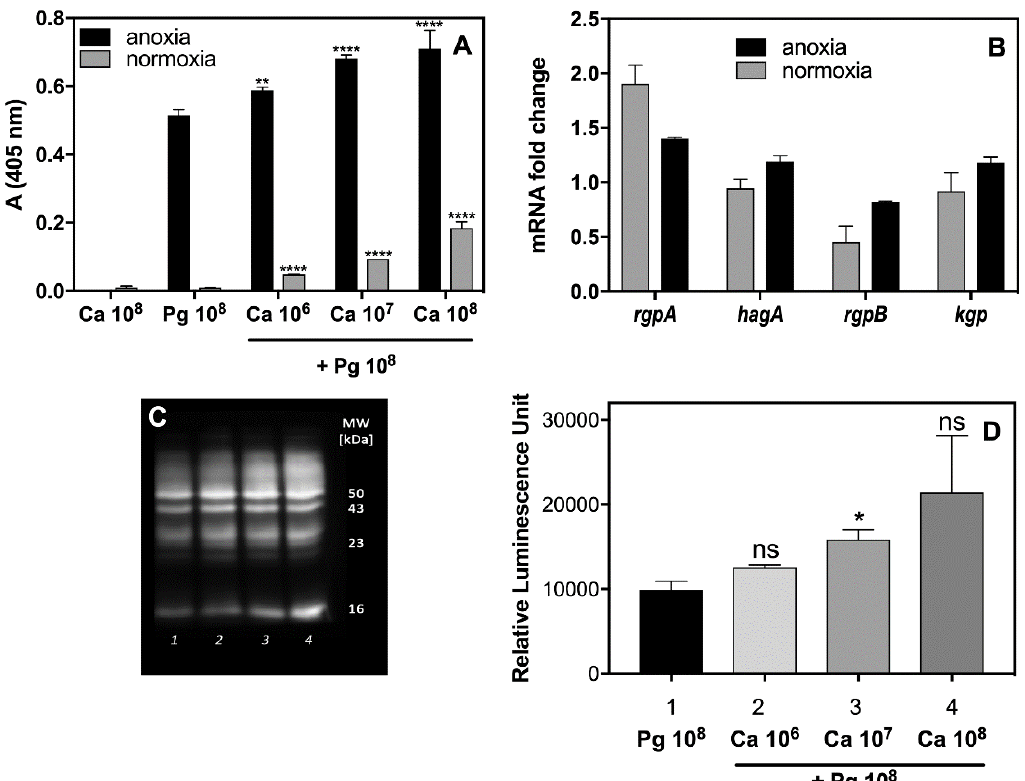
Figure 2. Changes in the gingipain activity and protease production by P. gingivalis growing within a C. albicans biofilm. ( A ) In assays for Rgp activity and ( C , D ) protein expression, the P. gingivalis cells grew (1) alone or in the presence of fungal cells at an MOI of (2) 100:1, (3) 10:1, (4) 1:1 for 24 h. The activity of Rgp was determined using BAPNA as the substrate followed by absorptiometric monitoring of enzyme kinetics. ( B ) qRT-PCR analysis of gingipain-encoding genes was performed for bacterial cells that formed a typical biofilm with C. albicans cells at an MOI of 100:1 during 3 h of mutual contact between both microorganisms. ( C ) Protein expression was analyzed by Western blotting and chemiluminescence detection with ( D ) respective quantification of the signals by phosphoimager. Each experiment was performed three times in triplicate, with the presentation of the representative data set. The gene expression was analyzed with one-way ANOVA with Sidak’s multiple comparisons test. Asterisks denote statistical significance ( p > 0.1234 ns, * p ≤ 0.0332, ** p ≤ 0.0021, **** p <